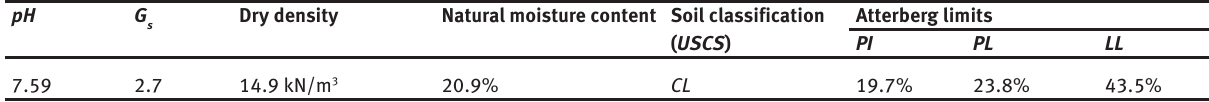
Table 1: Physical properties of the clay used in the study.